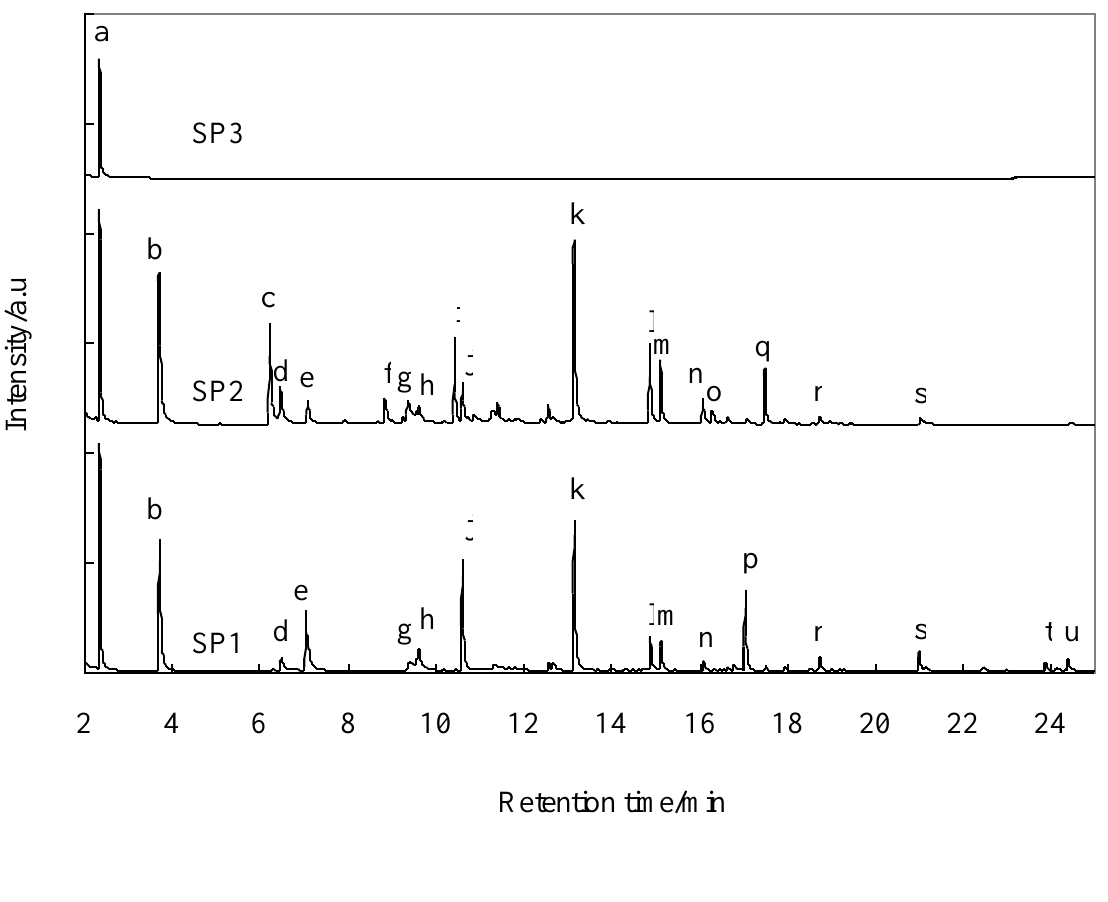
Figure 7. GC-MS spectra of tar in the gas collected at SP1, SP2, and